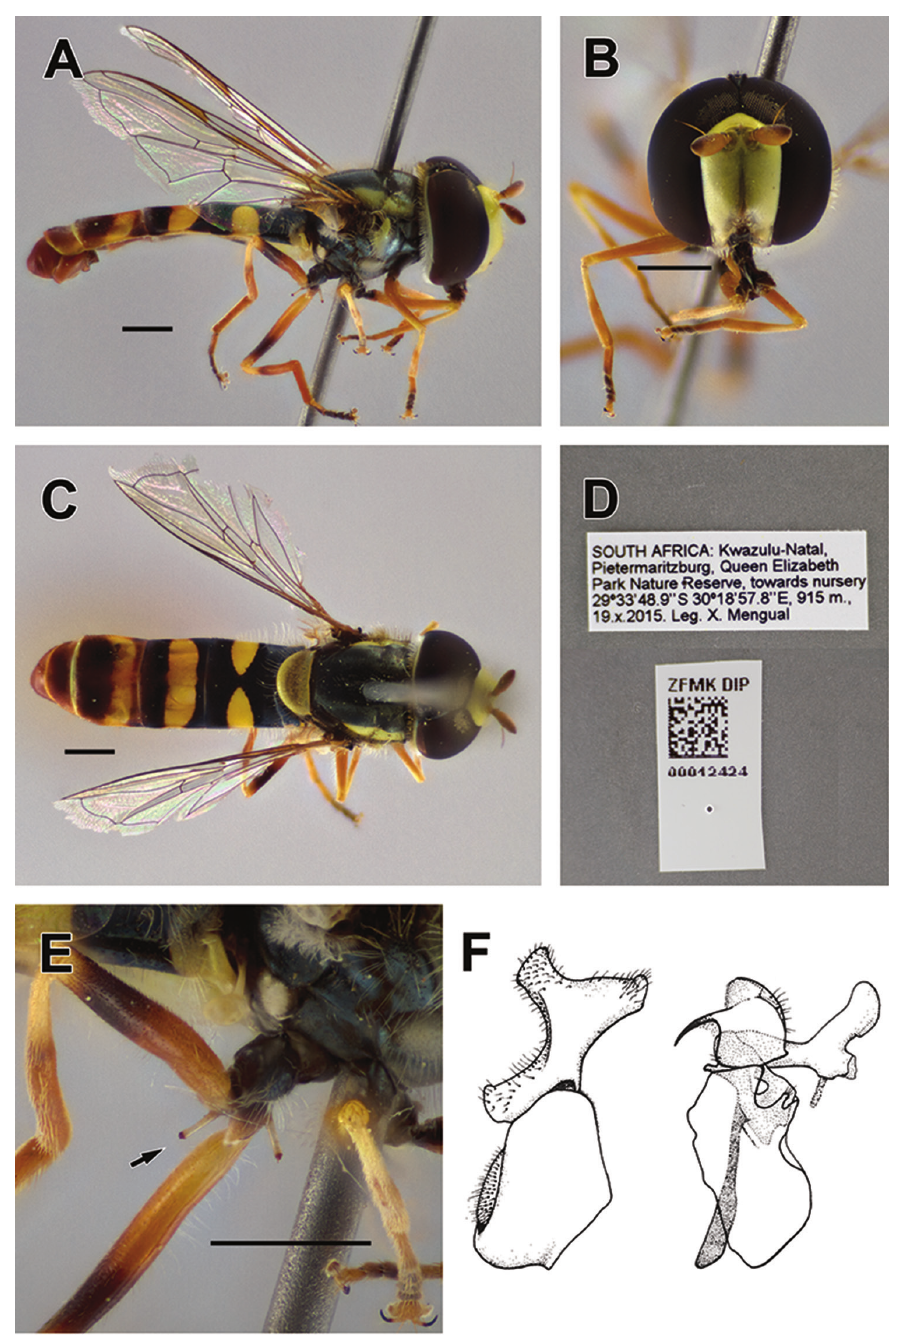
Figure 1. Ischiodon aegyptius (Wiedemann), male ZFMK-DIP-00012424: A Habitus, lateral view B Frontal view C Habitus, dorsal view D Labels E Metacoxa, metatrochanter and metafemur, lateral view F Male genitalia, lateral view (from Claussen and Barkemeyer 1987). Scale bars: 1